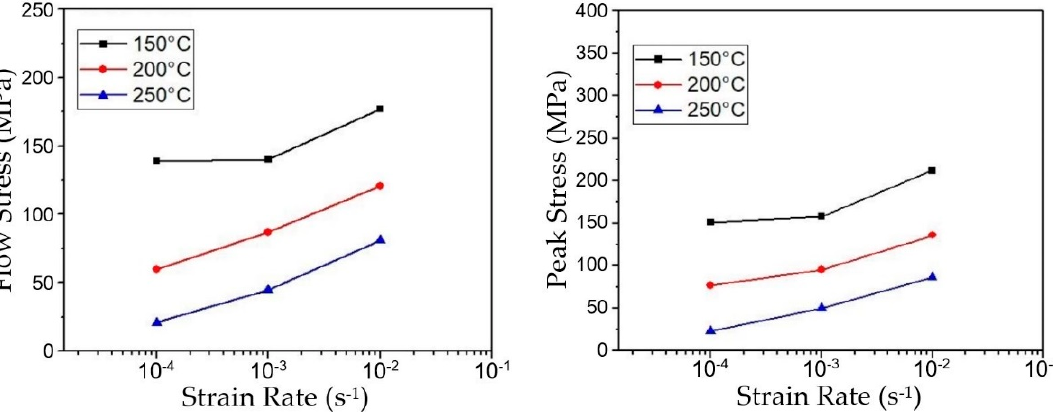
Figure 6. Flow and peak stress as a function of strain rate at different temperatures.